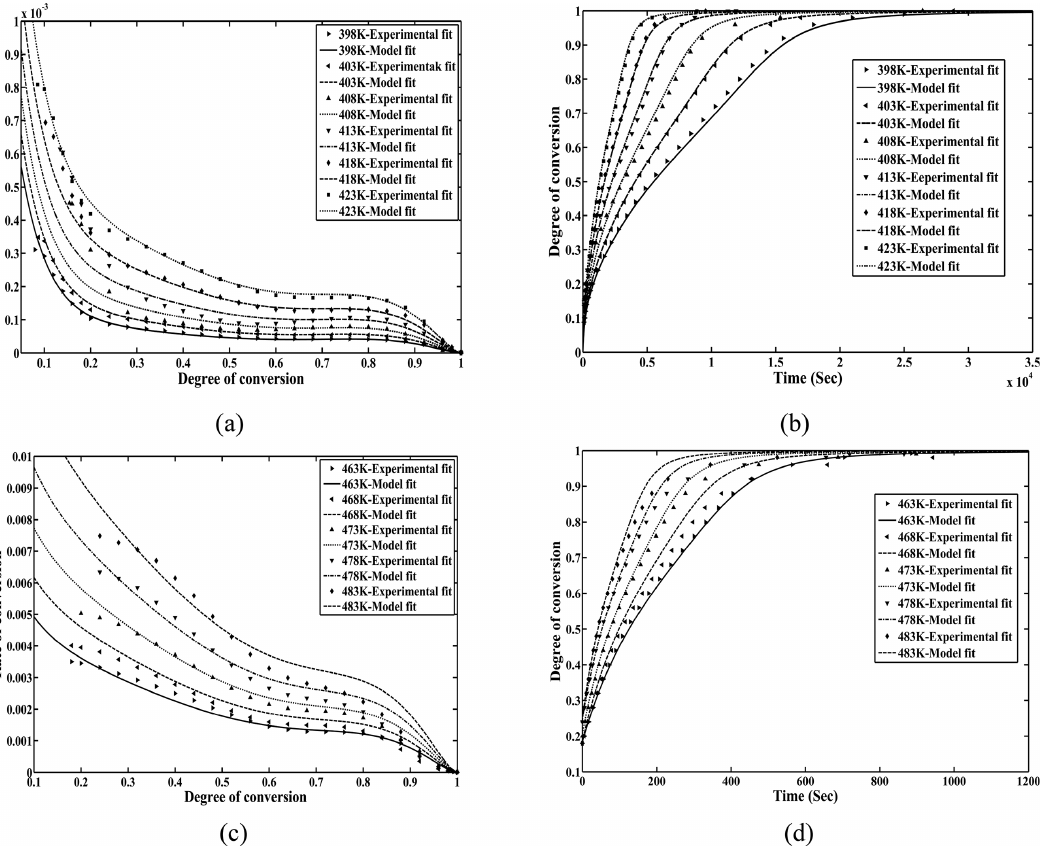
Figure 9: Comparison of experimental and model simulated (a) reaction rate at lower temperature range (b) degree of conversion at lower temperature range (c) reaction rate at higher temperature range (d) degree of conversion at higher temperature